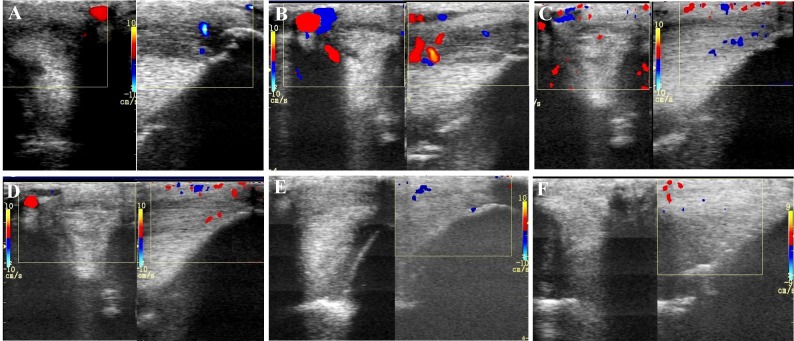
Transverse and longitudinal color Doppler ultrasonography projections prior to plasmid DNA encoding VEGF164 and FGF2 genes (A) and 20 (B), 40 (C), 90 (D), 180 (E), 360 (F) days after administration in horse #2 – SLB desmopathy.